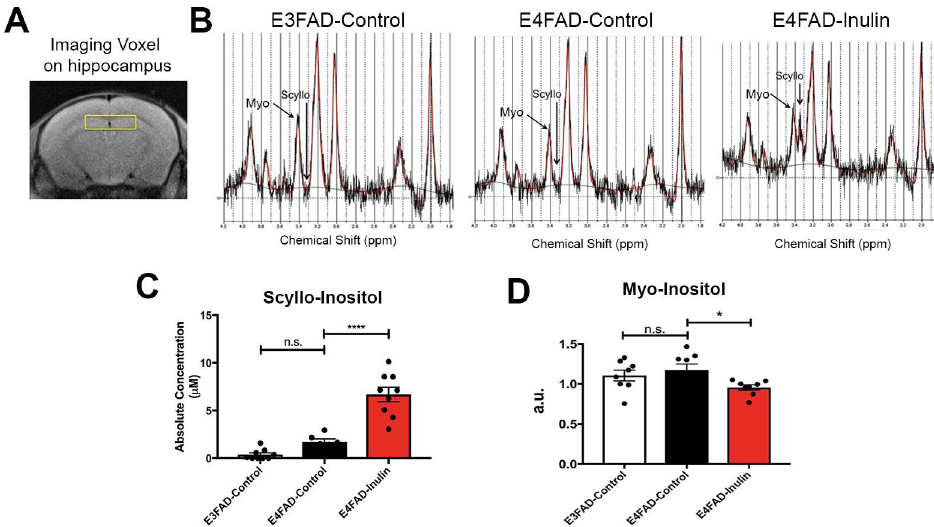
Fig 6. Analysis of inulin-induced changes in microbial metabolism in the brain. Scyllo-inositol was dramatically increased in the hippocampus of E4 FAD mice fed the prebiotic inulin compared to the E4 FAD mice fed the control diet. (A) Shows the voxel that was used for MRS. Representative spectra are shown for (B) the E3 FAD-Control, E4 FAD-Control, and E4 FAD-Inulin groups. The arrow indicates scyllo-inositol, which was dramatically increased in mice fed the prebiotic inulin. Scyllo-inositol (C) was significantly increased in E4FAD inulin mice compared to control fed E3FAD and E4FAD mice. Myo-inositol (D) was significantly decreased in E4FAD mice fed inulin. Data are the mean ± SEM, n.s. = not significant; ���� p < 0.0001.